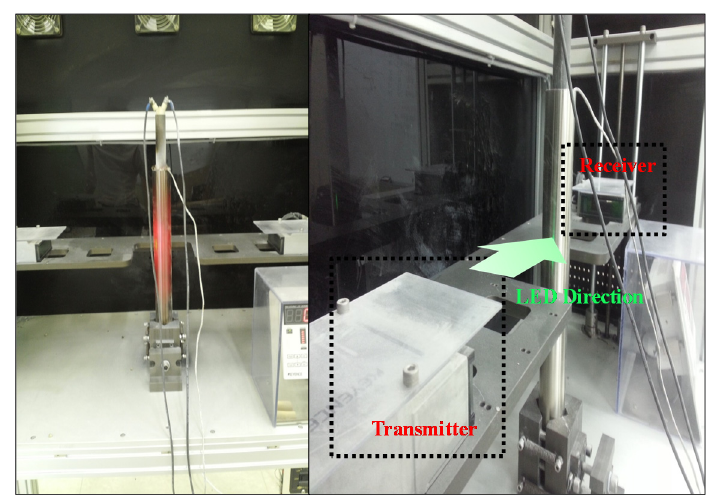
Figure 4. Measurement of thermal expansion.